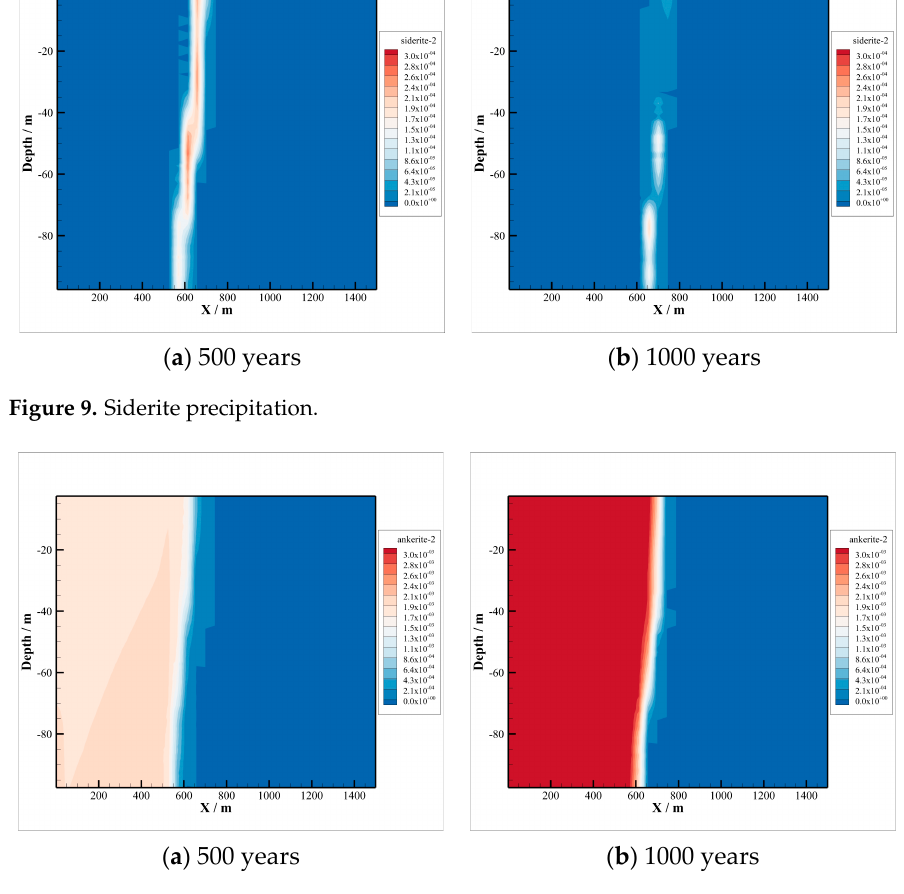
Figure 10. Ankerite precipitation.